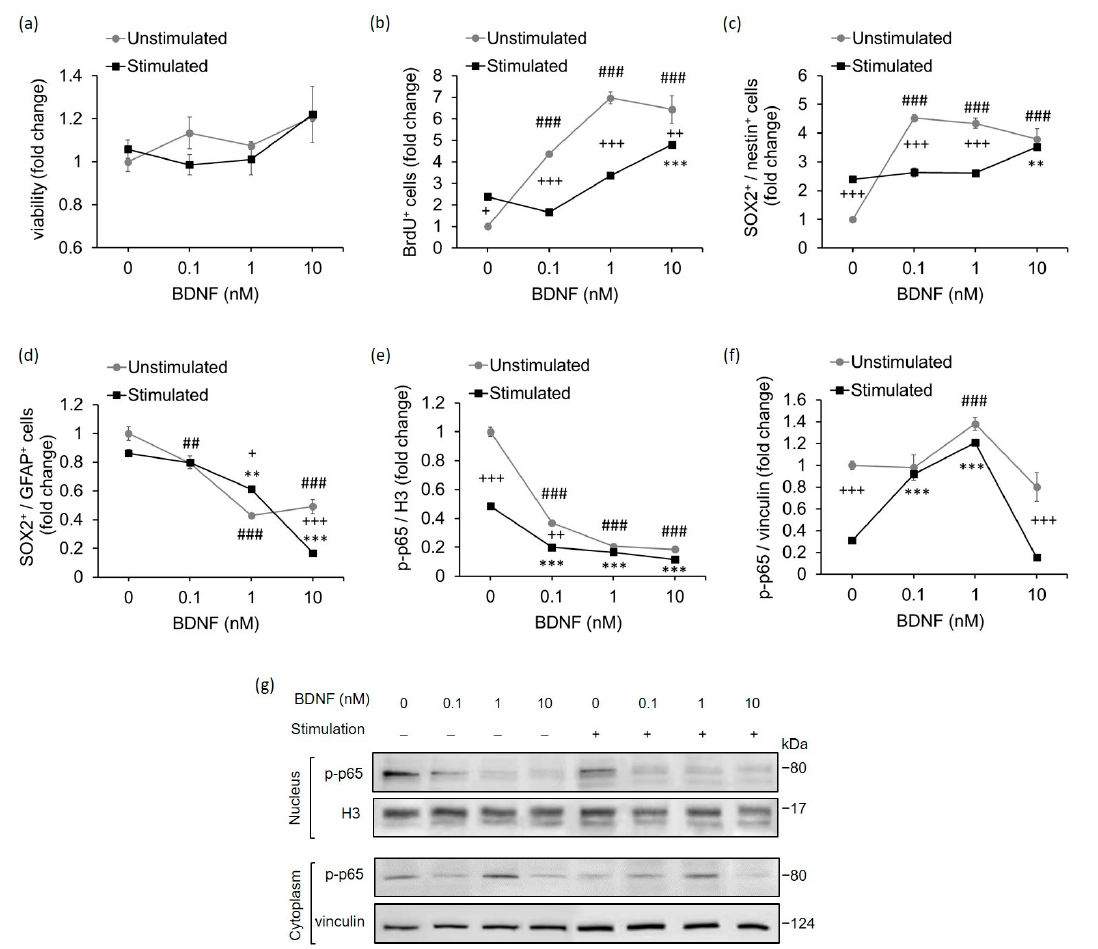
Figure 4. The combination of high-contrast stimulation and BDNF treatment augmented the neurodifferentiation potential and suppressed the pro-inflammatory phenotype of MCs. Quantification of ( a ) live MCs (fixable viability dye negative cells), ( b ) BrdU incorporation by MCs, ( c ) SOX2 + /nestin + MCs, and ( d ) SOX2 + /GFAP + MCs that were either stimulated by high contrast or unstimulated and cultured in the absence or presence of BDNF at the indicated concentrations (0.1 nM, 1 nM, 10 nM). Densitometric Western blot analysis of p-p65 expression in the ( e ) nuclear and ( f ) cytoplasmic extracts of high-contrast-stimulated and unstimulated MCs that were cultured in the absence or presence of BDNF at the indicated concentrations (0.1 nM, 1 nM, 10 nM). ( g ) Representative Western blot images of p-p65 expression in the nuclear and cytoplasmic extracts of high-contrast-stimulated and unstimulated MCs with or without BDNF treatment. Each experiment was repeated three times. The data are the means ± SEM. The results are presented as fold changes from the control group (unstimulated MCs without BDNF treatment). Differences between the stimulated and unstimulated groups treated with the same concentration of BDNF: + p < 0.05, ++ p < 0.01, +++ p < 0.001. Differences between the high-contrast-stimulated group treated with BDNF and the high-contrast-stimulated group without BDNF treatment: ** p < 0.01, *** p < 0.001. Differences between the unstimulated group treated with BDNF and the unstimulated group without BDNF treatment: ## p < 0.01, ### p < 0.001 (two-way ANOVA followed by Tukey’s post-hoc test).